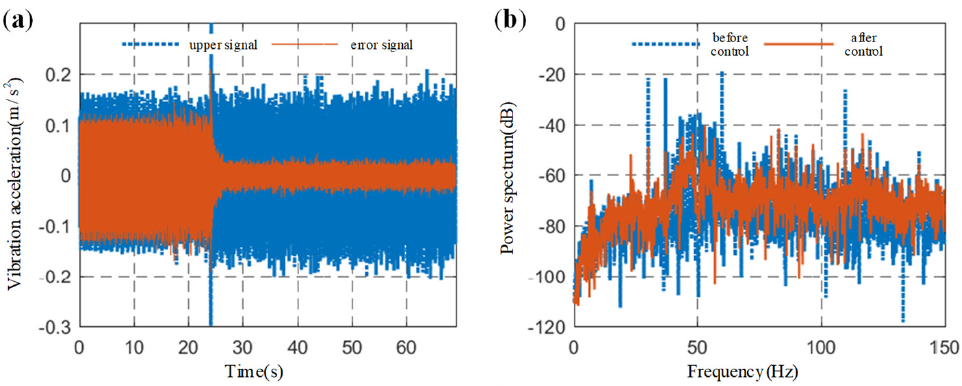
Figure 12. The test results of constant frequency excitation active control (control scheme 2): ( a ) time history diagram; ( b ) power spectrum of error signal.